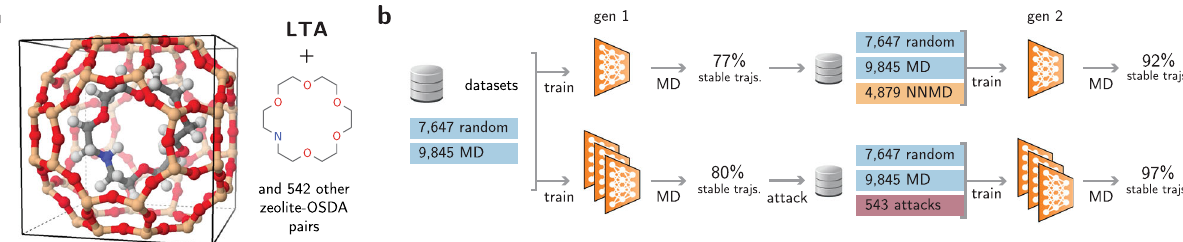
Fig. 6 Adversarial attacks applied to zeolite-molecules systems. a Example of zeolite-molecule pair simulated in this work. In total, 543 different poses were used as starting con fi gurations for the simulations (see Supplementary Table 3). b Active learning strategies for training a NN potential for zeolite- molecule systems. A traditional, MD-based loop is compared with adversarially trained NN